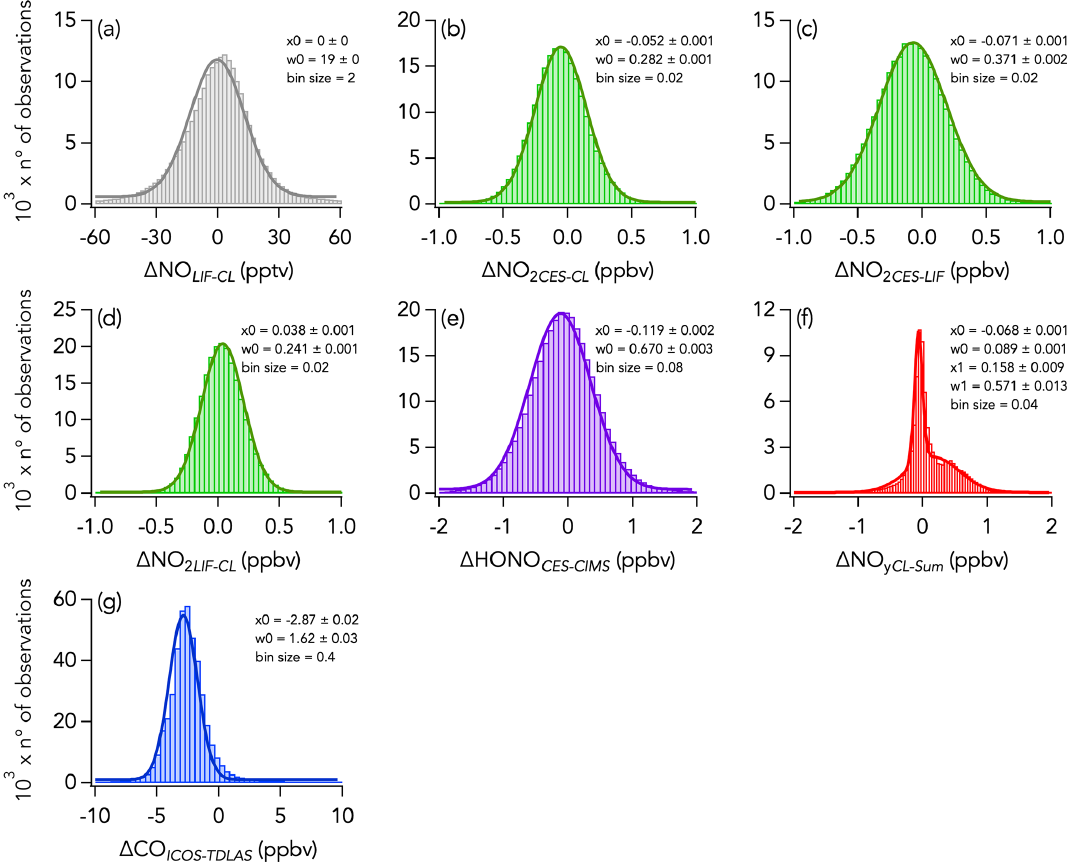
Figure 5. Histograms of the absolute difference of 1s measurements of (a) NO, (b–d) NO 2 , (e) HONO, (f) NO y , and (g) CO for the entire campaign. Parameters of the Gaussian fit to the histogram are indicated in each panel, with x 0 and w 0 being the central value and the width of the fit, respectively. Note that in panel (f) a double Gaussian was fitted to the histogram and that the parameters for the second mode are given by x 1 and w